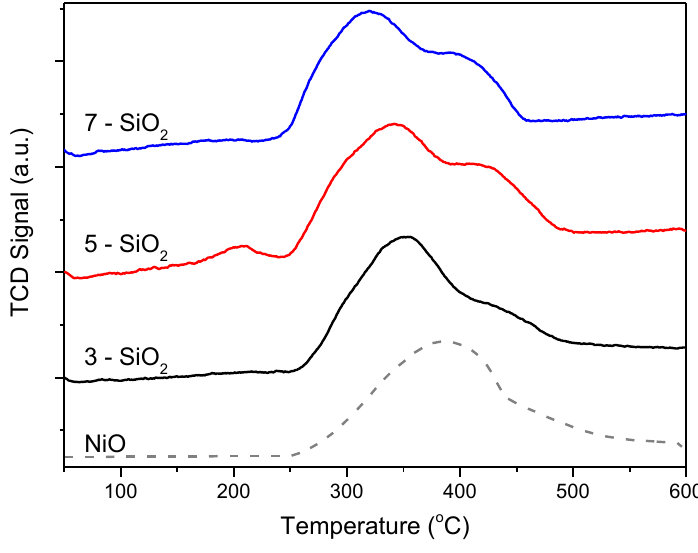
Figure 4. H 2 -TPR results of 5% Ni on 3, 5 and 7-SiO 2 and bulk